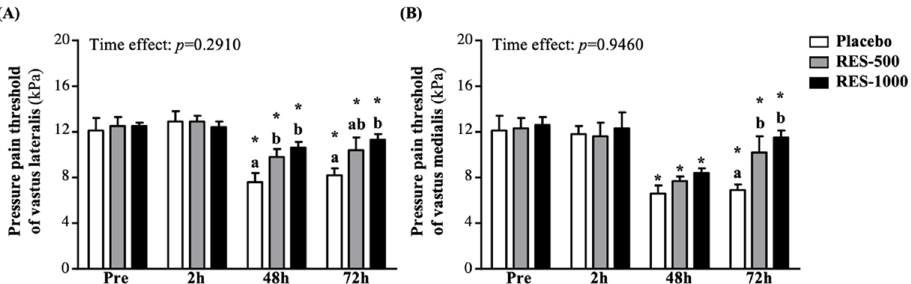
Figure 5. Effect of supplementation with RES on pressure pain threshold of ( A ) vastus lateralis and ( B ) vastus medialis. Data are presented by mean ± SEM. Different superscript letters (a, b) indicate significant differences among the groups at p < 0.05, and administration effects were statistically analyzed with a paired Student’s t -test, * p <